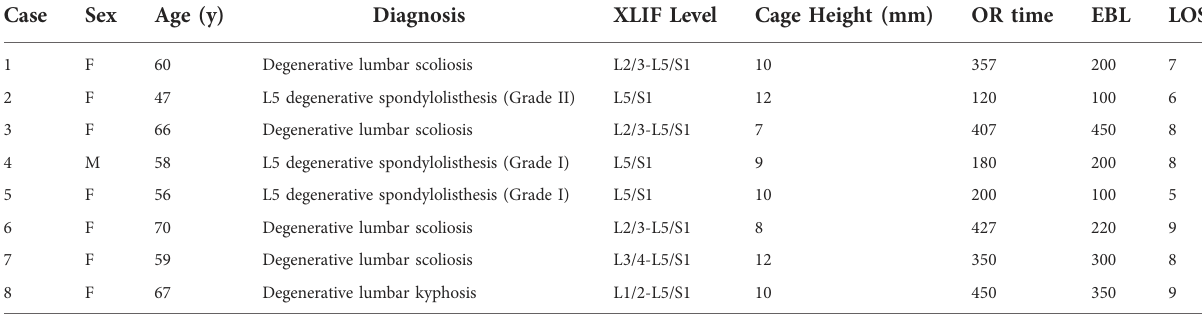
TABLE 1 Patient demographics of the surgery.